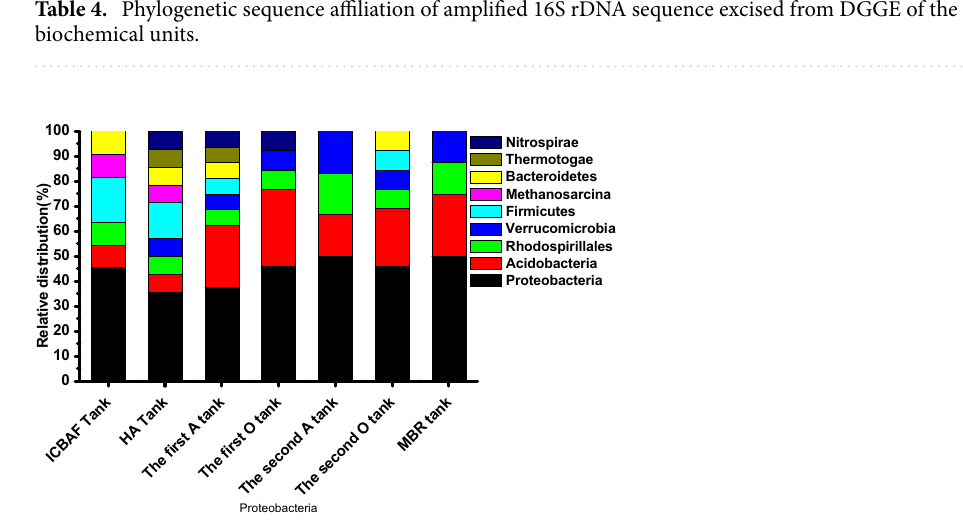
Figure 5. Relative abundance of the major bacterial community at phylum levels (only higher than 1% was